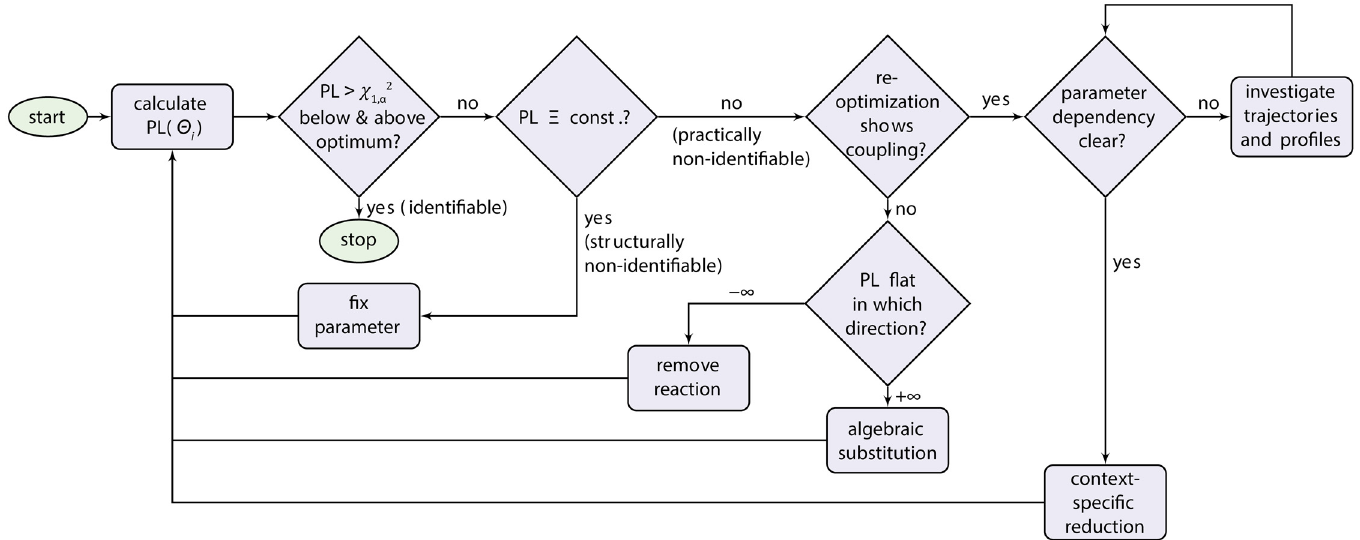
Fig 6. Typical flow-chart for model reduction based on the profile likelihood. The depicted steps are to be applied for each parameter individually, starting with the calculation of the respective profile likelihood. After detection, the procedure resolves non-identifiabilities by fixing parameters, removing reactions, performing algebraic substitutions, or context-specific reductions. The method terminates when all parameters of interest are